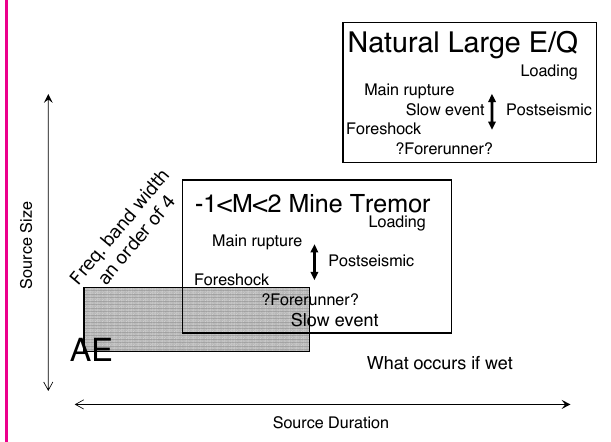
Figure 6. Comparison of sets of phenomena observed.